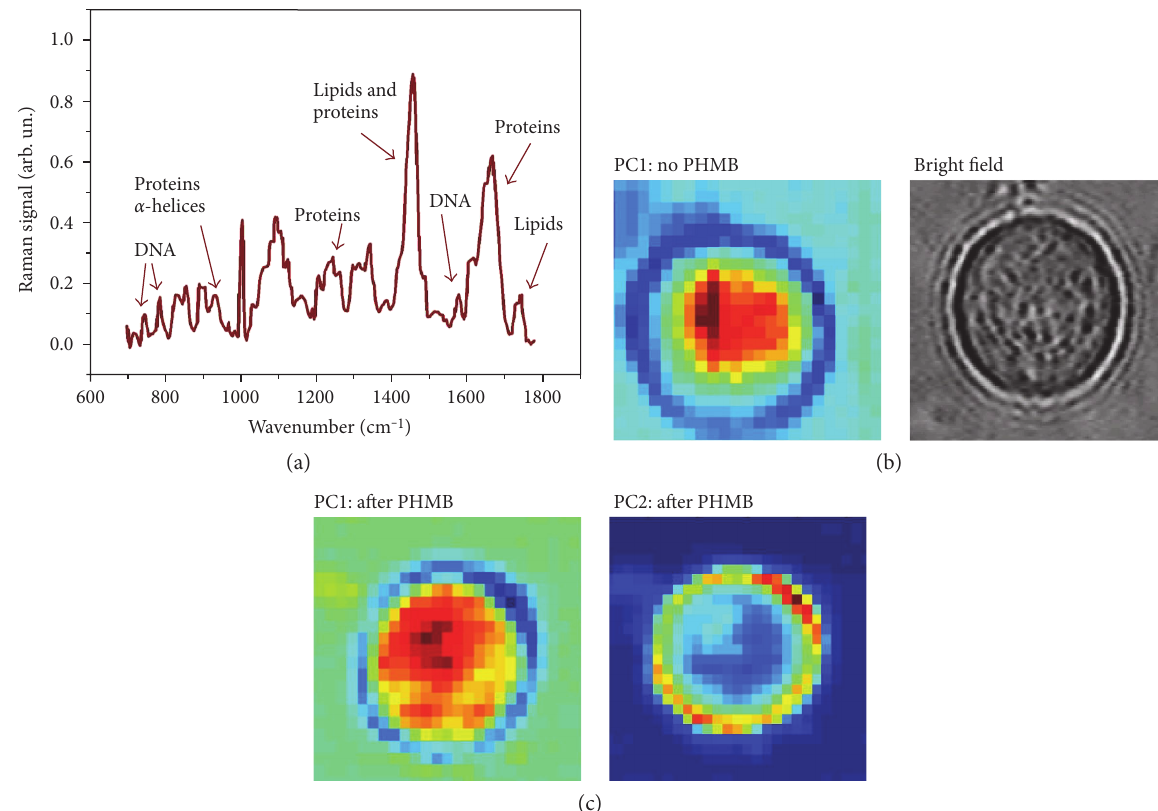
Figure 3: (a) A typical Raman spectrum from a live Acanthamoeba . (b) Score maps of PC1 component for an A ., before exposure to PHMB (left) compared with its bright fi eld image (right). (c) Score map of PC2 (left) and PC3 (right) components after 6 hours of A . exposure to